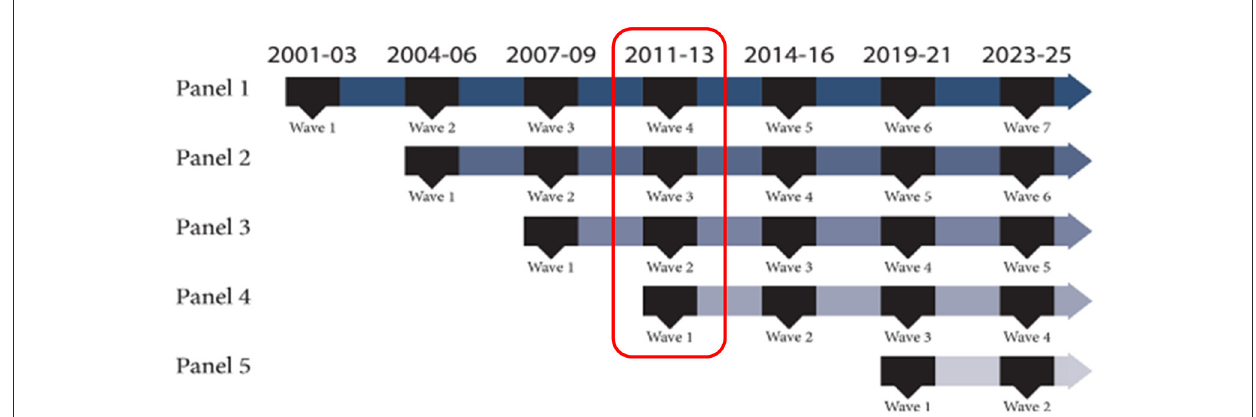
FIGURE1 Depiction of the Millennium cohort study’s multi-panel, multi-wave design. The red box identifies data utilized for the present research.